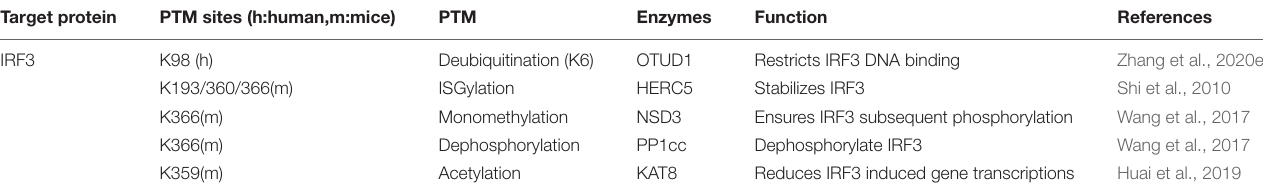
TABLE 4 | Modifications of IRF3 during virus infection. Target